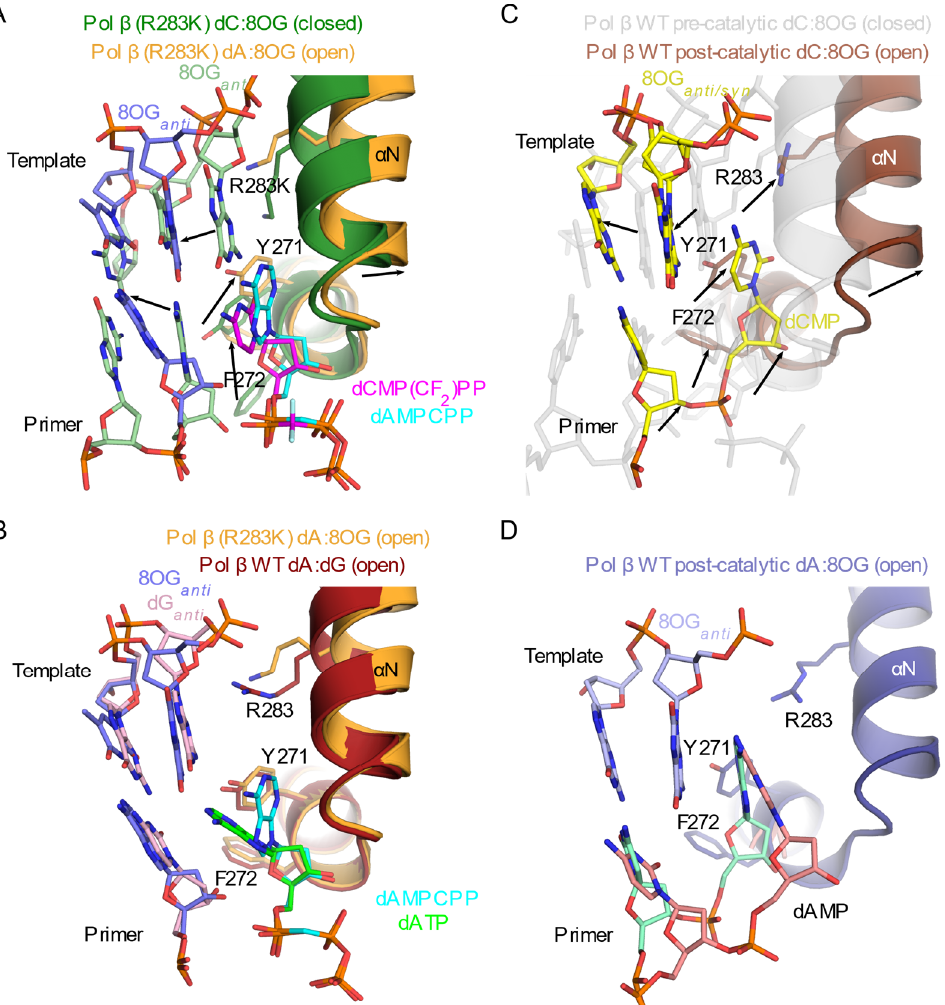
Figure 5. Comparison of structural rearrangements during mutagenic base pairing. ( A ). Superposi- tion of pre-catalytic ternary complex structures of Pol β (R283K) mutant bound to single-nucleotide gapped DNA substrate with template 8OG and either incoming dCMP(CF 2 )PP (PDB ID code 4GXJ [33]; protein in dark green, DNA in light green, incoming nucleotide in magenta) or dAMPCPP (PDB ID code 4GXK [33]; protein in orange, DNA in blue, incoming nucleotide in cyan). Black arrows show structural rearrangements between closed and open conformations. ( B ). Superposition of pre-catalytic complex structures of Pol β (R283K) with dAMPCPP:8OG mispair (PDB ID code 4GXK [33]; protein in orange, DNA in blue, incoming nucleotide in cyan) and wild-type Pol β with dATP:dG mispair (PDB ID code 4LVS [32]; protein in maroon, DNA in light pink, incoming nucleotide in green). ( C ). Superposition of wild-type Pol β in pre- (PDB ID code 4RPX [55], transparent gray) and post-catalytic nicked complex of wildtype Pol β with newly incorporated dC opposite the template 8OG (PDB ID code 4RQ0 [55], protein in brown, DNA in yellow). The template 8OG is observed in both syn and anti conformations. Transitions of protein side chains and DNA nucleotides are indicated by black arrows. ( D ). Post-catalytic nicked complex of wildtype Pol β with newly incorporated dA opposite the template 8OG (PDB ID code 4RQ6 [55], protein in dark blue, DNA template strand in light blue). The template 8OG is observed in a single conformation ( anti ), while the primer strand is modeled with alternate conformations (pink and aquamarine). Secondary struc- tural elements are shown in cartoon representation, and key active site components are drawn in stick.